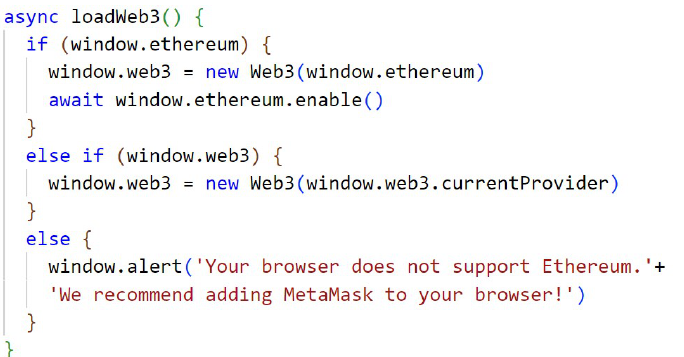
Figure A1. Communication with